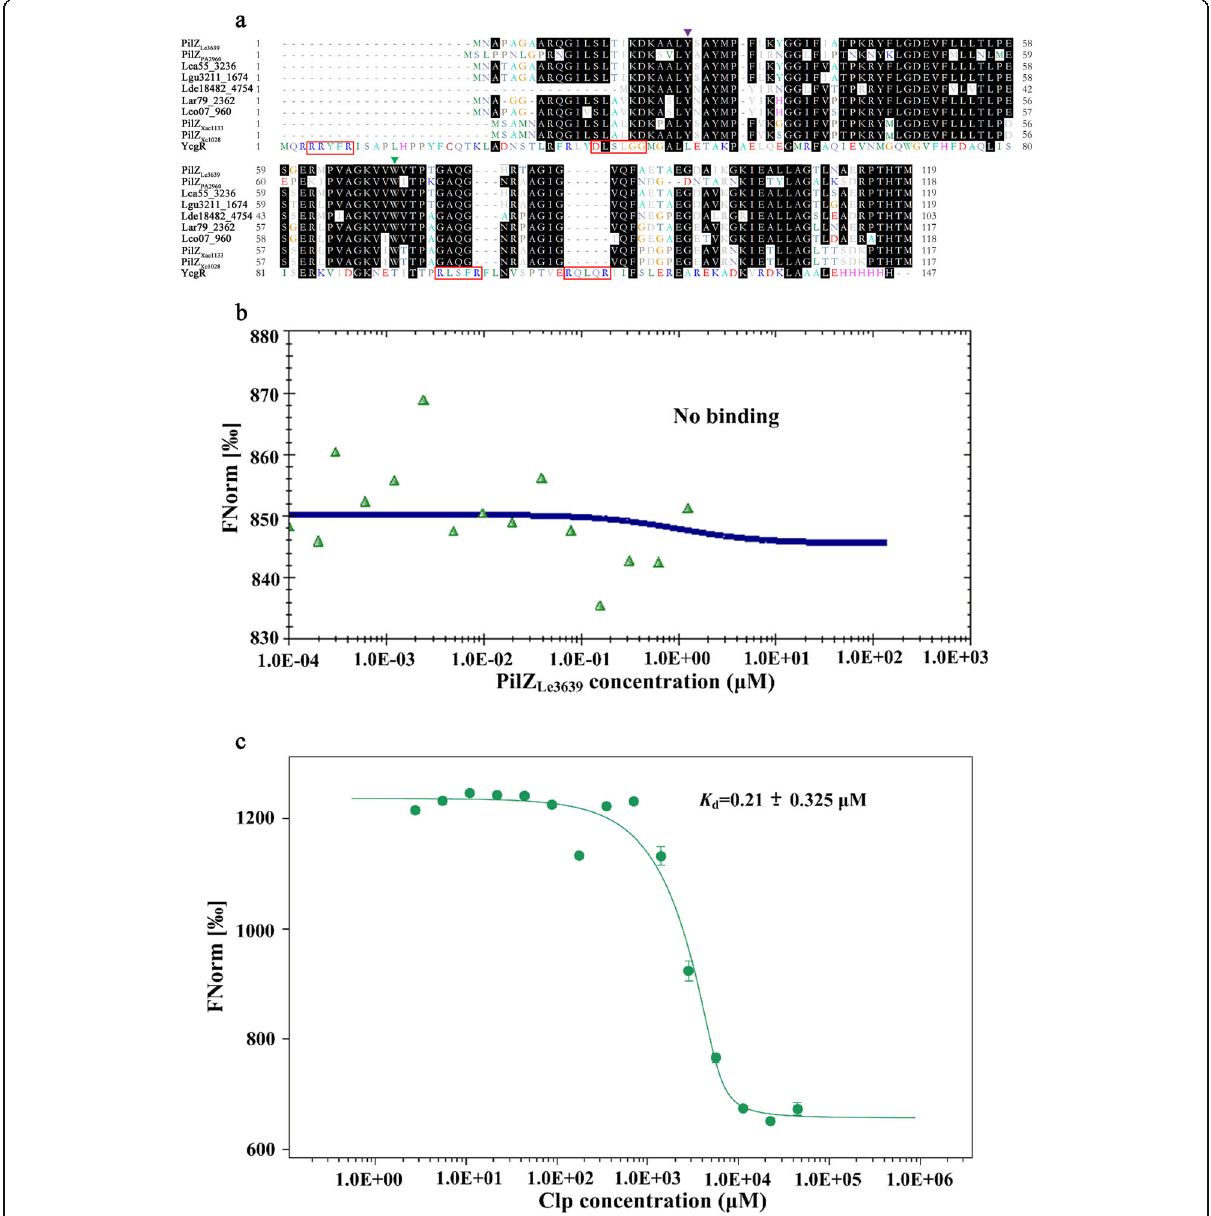
Fig. 1 PilZ Le3639 is a stand-alone PilZ domain and unable to bind c-di-GMP. a Multiple sequence alignment of the PilZ Le3639 -like proteins. PilZ Le3639, PilZ PA2960, Lca55_3236, Lgu3211_1674, Lde18482_475, Lar79_2362, Lco07_960, PilZ Xac1133 and PilZ Xc1028 indicated these stand-alone PilZ domains from Lysobacter enzymogenes OH11, Pseudomonas aeruginosa PA01, L. capsisi 55, L. gumosus 3.2.11, L. defluvii DSM18482, L. arseniciresistens ZS79, L. concretionis Ko07, Xanthomonas citri and X. campestris , respectively. YcgR (PDB entry 5Y6G), is a c-di-GMP-binding protein from E. coli. The RxxxR and [D/N] xSxxG that are required for c-di-GMP binding (Guzzo et al. 2009) are highlighted by red boxes. Two conserved residues (Y24 and W71) in the selected stand-alone PilZ domains are indicated by purple and green triangles, respectively. b Microscale thermophoresis (MST) assay showed PilZ Le3639 failed to bind with c-di-GMP, while c Clp, a known c-di-GMP-binding protein (Xu et al. 2018), showed moderate binding affinities with c-di-GMP determined by